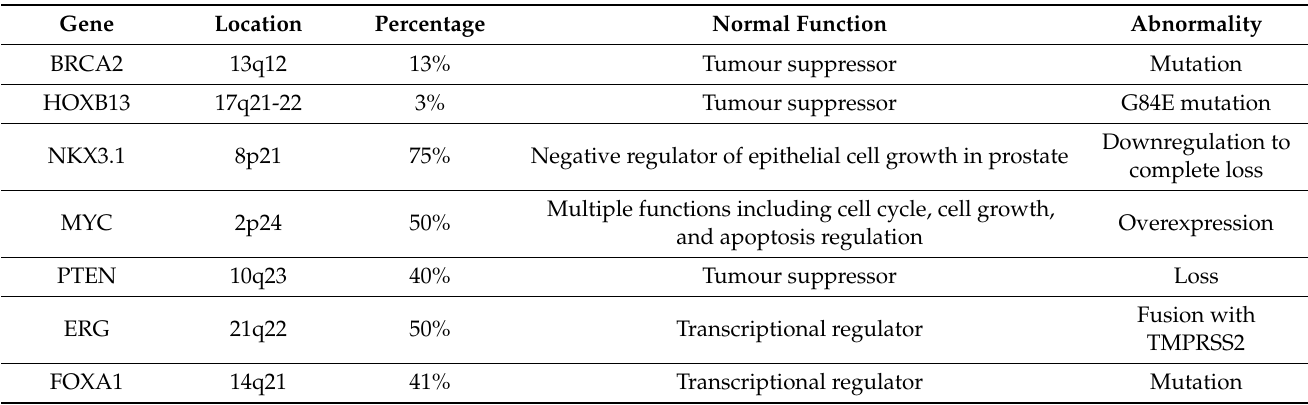
Table 1. Summary of the main genes involved in prostate